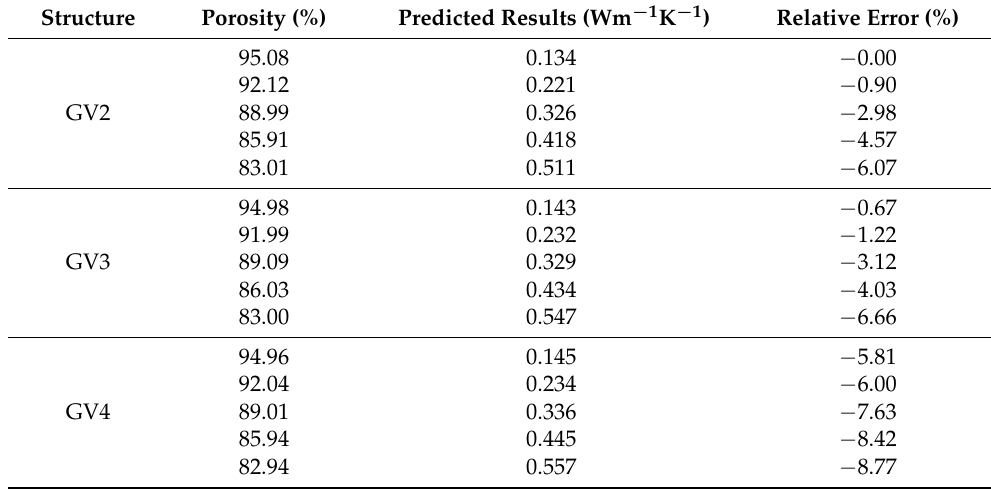
Table 7. Calculated results of predicted effective thermal conductivity of three-dimensional gradient random porous materials based on Voronoi